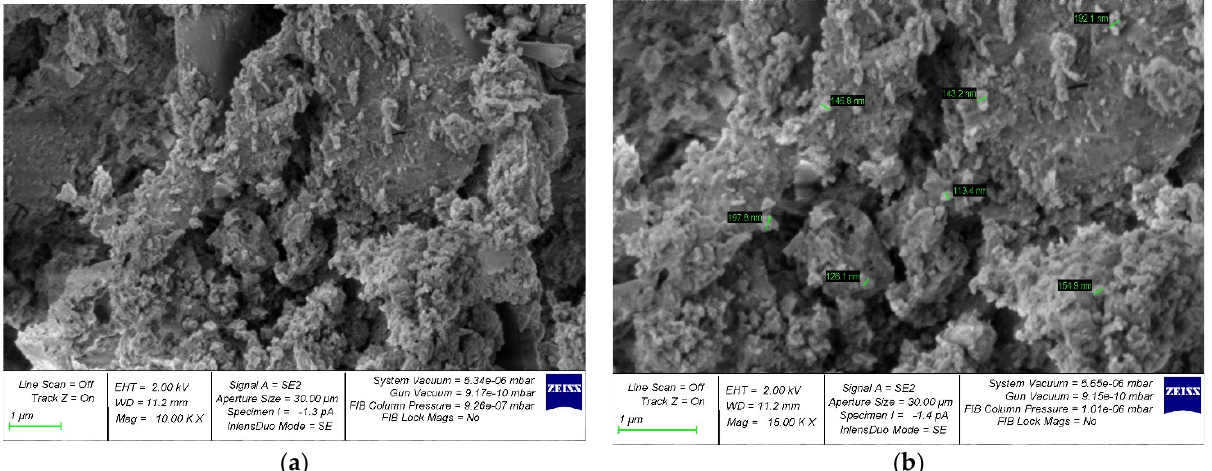
Figure 5. Samples with nanosilica content of 2.5% by weight of cement at magnifications of ( a ) 10,000× and ( b ) 15,000×.